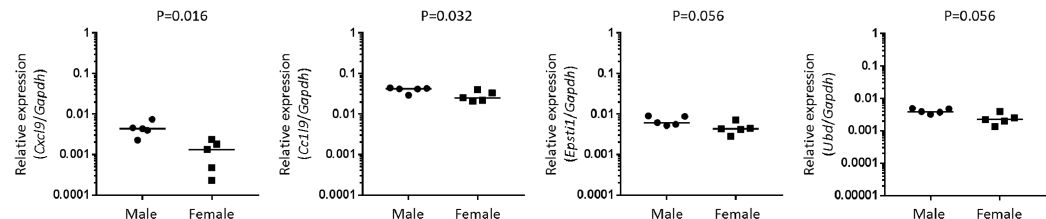
Figure 3. Disease-relevant chemokine genes are still significantly upregulated in male lacrimal glands from lymphocyte-deficient NOD-SCID mice. Graphs depict gene expression of indicated genes normalized to that of Gapdh in lacrimal glands of 14-16 week old male or female NOD-SCID mice. Symbols represent individual mice, lines are medians. p values by Mann-Whitney test applied to log-transformed ratios.